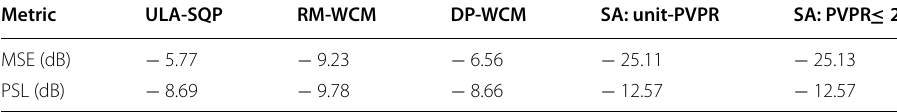
Table 2 Comparisons of performance in Example 2 Metric